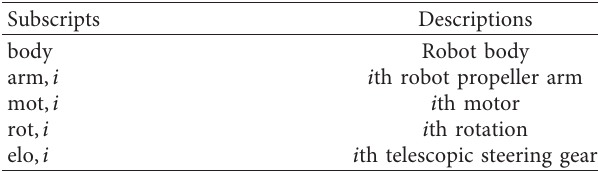
Table 1: Meaning of subscript letter.